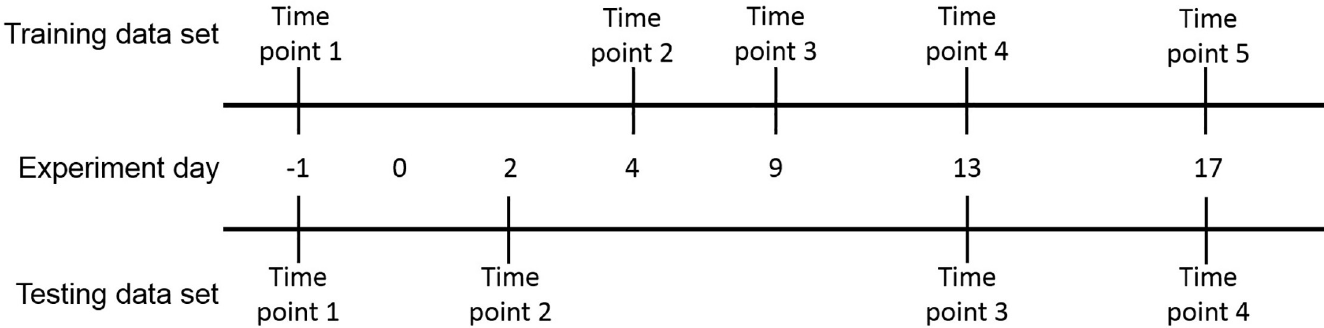
Fig 1. Sampling schedule for metabolite determination in the training and testing groups. Day -1 represents the pretreatment time point. For both the training and testing data sets, starting on day 0 cats in the treatment groups for each set received 0.3 mg/kg meloxicam every 24h till the end of the study. Cats in the control groups received 0.1 mL/kg body weight of saline every 24h until the studies